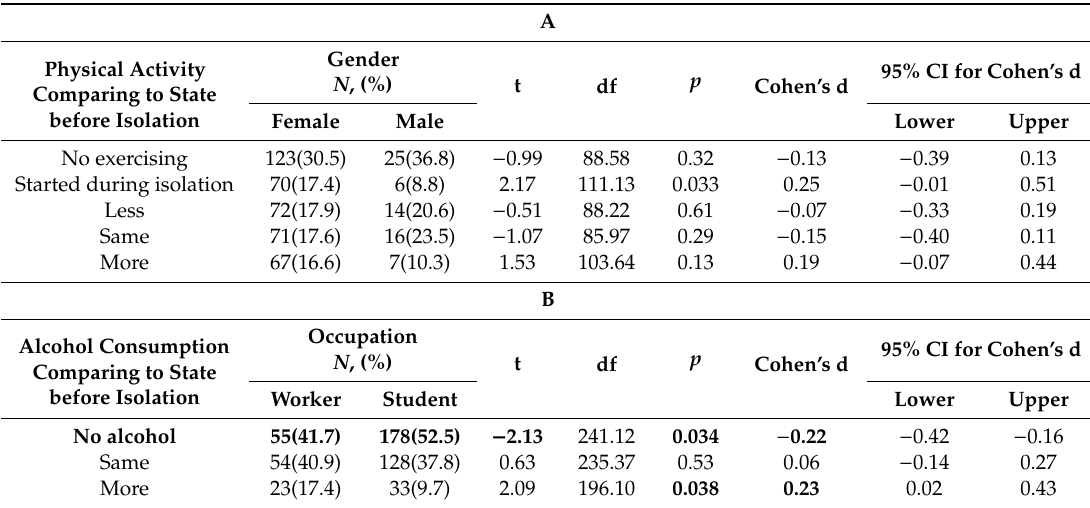
Table 4. Gender di ff erences in physical activity during home confinement (A) and occupation disparities for alcohol consumption compared to before home confinement (B), n = 471.